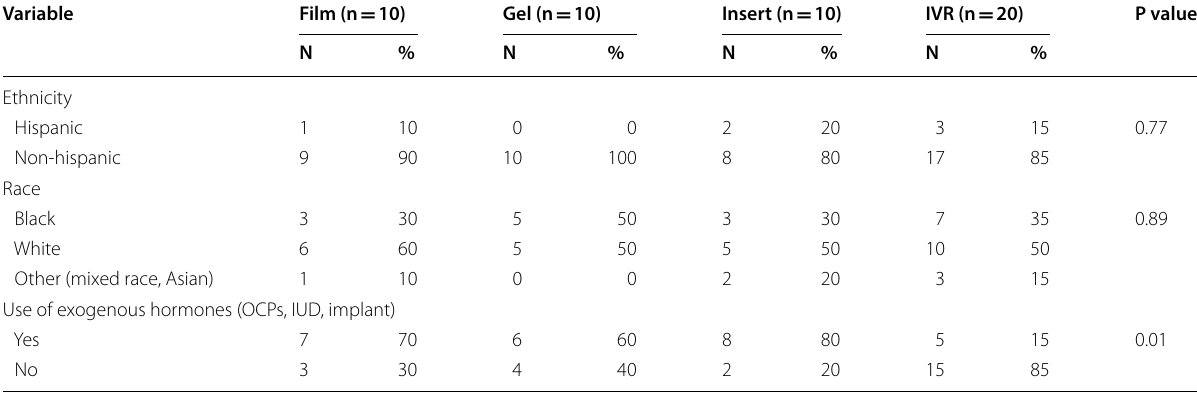
a P values were generated using Fisher’s exact